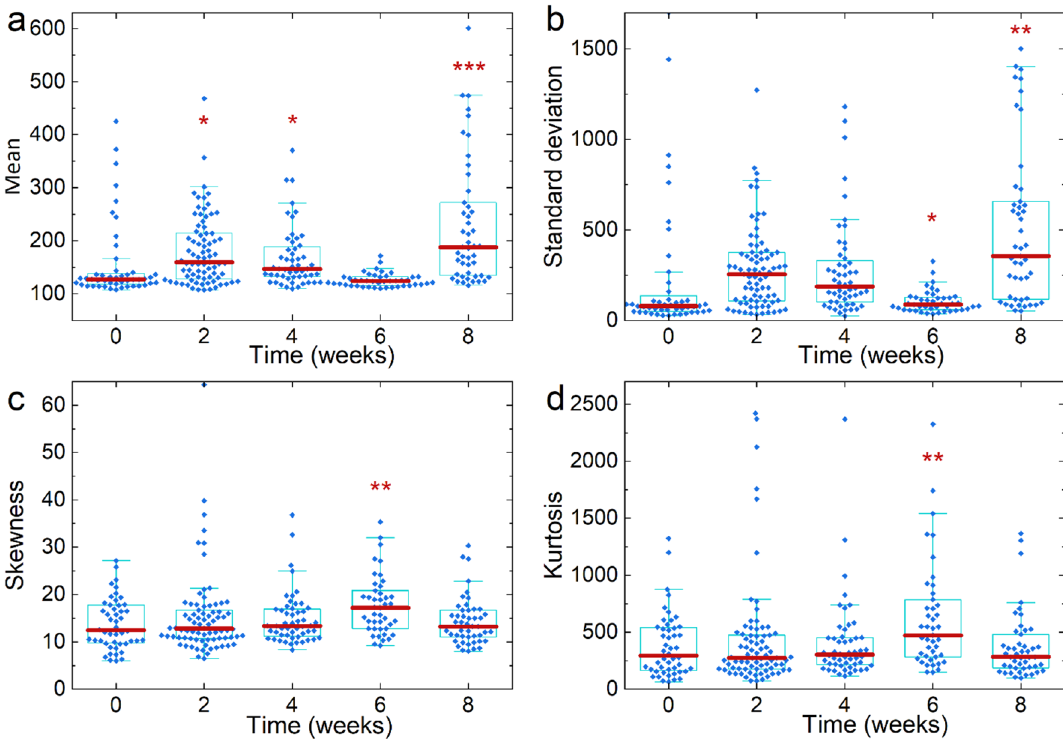
Figure 4. FOS parameters determined inform SHG images of control samples and during the PAH progression. ( a ) Mean, ( b ) standard Deviation, ( c ) skewness, ( d ) kurtosis. The statistical significance of the difference of different distributions relative to the control is p < 0.1*, p < 0.01**, p < the number of the areas of high contrast compared to the control. This is likely associated with the formation of highly dense collagen bundles and the appearance of foci of collagen synthesis. A subsequent drop of contrast indicates homogenization of collagen distribution during the 4th and 6th week of PAH progression. However, the terminating phase of PAH is accompanied by a significant increase of the number of high contrast areas and occurs due to thickening of collagen bundles. Calculated energy is presented in Fig. 5b. Energy values may vary from 0 to 1. The absence of dominant gray levels in the image corresponds to low energy values. Thus, low energy at the 2nd and 8th week depicts collagen fiber ordering and spreading. Correlation is a measure of the presence of periodic structures in an image. Zero correlation arises from a uniform image 9,40 . Calculated correlation of SHG images is presented in Fig. 5c. Here, correlation is within the range of 0.9–1.0, indicating the presence of some periodic structures, both, it the case of healthy rats in the control group and rats with PAH at different stages of progression. Examples of such periodic structures are presented in Fig. 5f. These data indicate that despite the changes of the anisotropy of fiber orientation (Fig. 3), collagen packing into fibers characterized by periodicity is not significantly disrupted during the PAH progression accord- ing to small variations in correlation values. Nevertheless, the latter are significantly distinguishable (Fig. 5c). The evolution of entropy values (Fig. 5d) correlates with the data discussed above. Low entropy of control samples and lung tissue at the 6th week of PAH-associated fibrosis development indicates the less clearly sepa- rated fibers in the selected area in comparison with other stages of desease progression. This could be caused, e.g., by the fiber swelling during inflammation on the 6th week of PAH progression 41 . High entropy values on the 2nd, 4th, and 8th weeks of PAH are caused by bright and distinct but not necessarily ordered collagen fibers standing out from a homogeneous background. IDM is a measure of how tightly GLCM elements are distributed to its diagonal. IDM equals 1 for a diagonal GLCM matrix. Thus, IDM measures the amount of local uniformity present in the image and is a metric of pixel similarity to its neighbours 9 . The higher is the IDM value, the denser or thicker are the collagen fibers. A decrease in the IDM values during the PAH progression (Fig. 5e) indicates the spreading of the network of thin and dis- ordered collagen fibers and the development of fibrosis. These data are in good agreement with Energy values, confirming the growth of collagen fibers into the lung tissue both near and away from the walls of blood vessels. Physiologically, the observed collagen changes during 5-week period of PAH progression among other things are associated with gradual accumulation in lung tissue of inflammatory markers including monocyte chem- oattractant protein 1 (MCP-1) and interleukin-6 (IL-6) as demonstrated in 42 . Treatment with silibinin (C-X-C chemokine receptor type 4 inhibitor) reduces the PAH symptoms during the first two weeks due to the down- regulation of the gene expression of inflammatory markers in pulmonary arteries but not in the lung tissue. How- ever, silibinin fails to ameliorate PAH at later stages. At that time, it becomes an irreversible condition because of MCP-1 and IL-6 accumulation in the tissue. Increased MCP-1 induces collagen synthesis by lung fibroblasts